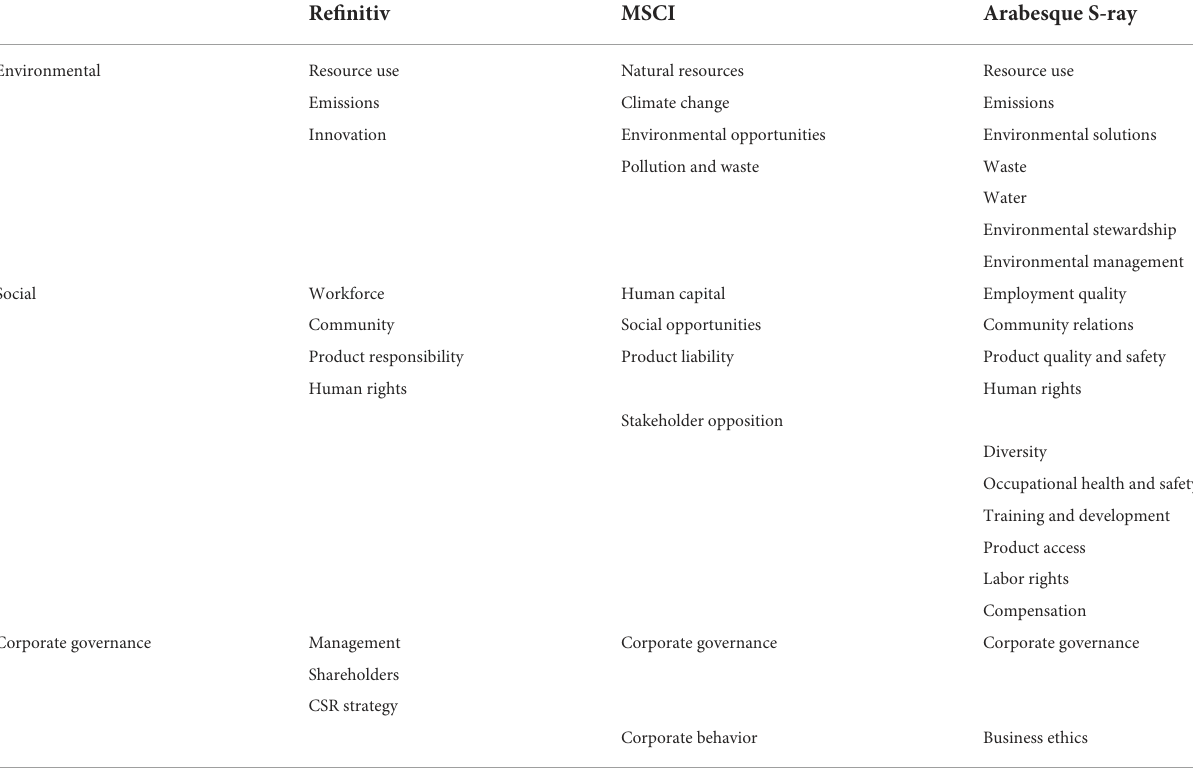
TABLE 2 Comparison of ESG score rating